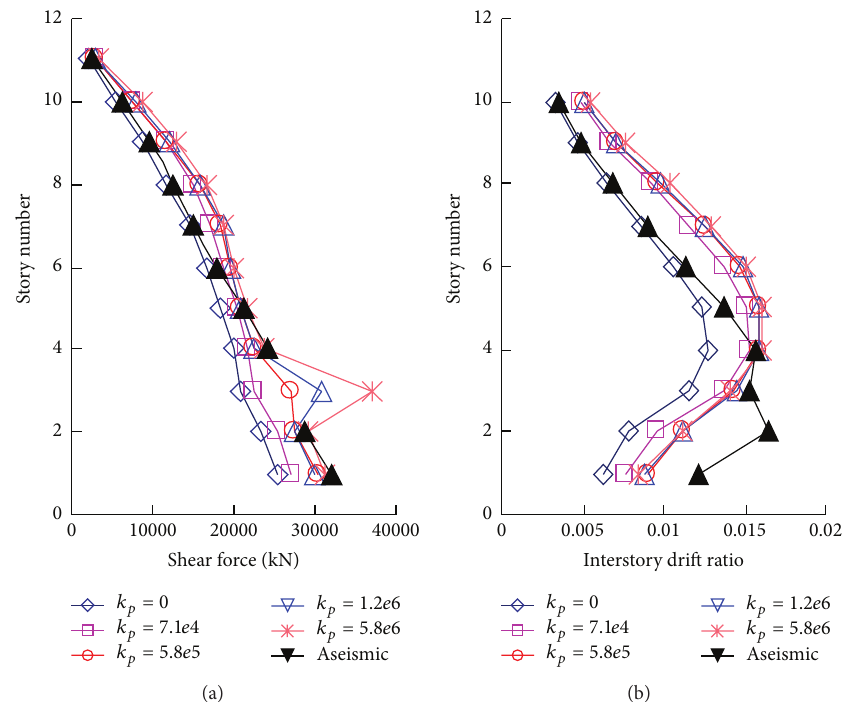
Figure 14: Impacts of pounding stiffness on responses of midstory isolated structure. (a) Peak shear force along height of building; (b) plastic interstory drift ratio.